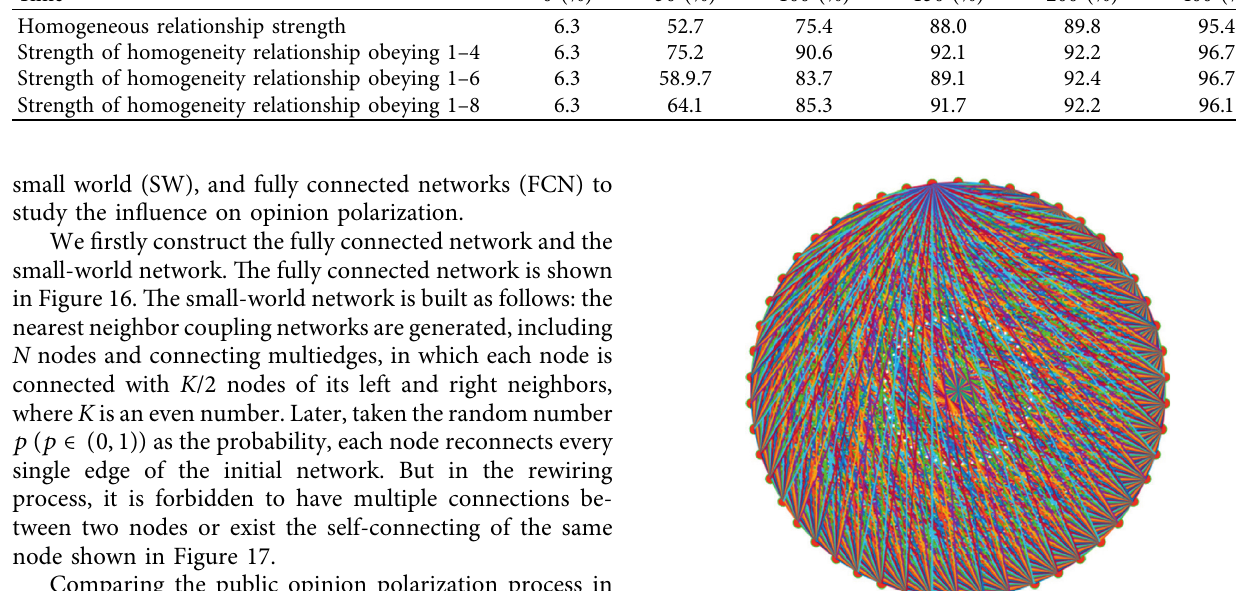
Table 5: Statistical table of polarization ratio of individuals under different relationship intensities (mean value of 5 experiments). Time